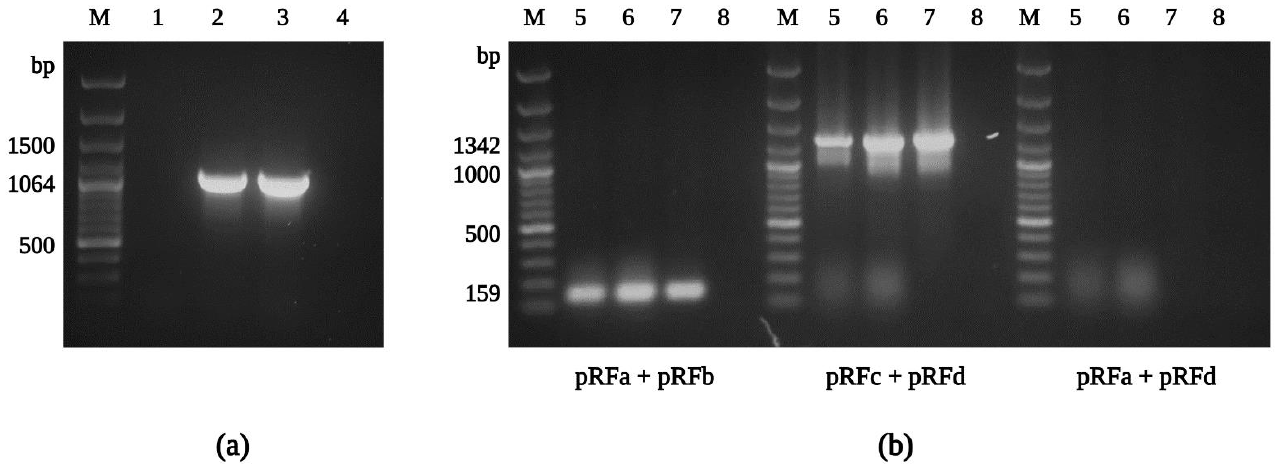
Figure 5. Agarose gel electrophoresis of PCR amplicons of the omp A gene and plasmids from R. felis Danube. The partial sequence of the gene omp A was amplified using R. felis -specific primers Rf190.1790fw and Rf190.2857rev ( a ). The pRF plasmid was detected using the primer pairs pRFa- pRFb (expected size 159 bp) and pRFc-pRFd (expected size 1342 bp), but not pRF δ (primers pRFa and pRFd; expected size 1168 bp) ( b ). M: molecular marker; 1: uninfected XTC-2 cells; 2: infected XTC-2 cells; 3: purified R. felis Danube; 4: negative control; 5: infected XTC-2 cells; 6: purified R. felis Danube; 7: extracted plasmid DNA from purified R. felis Danube; 8: negative control.